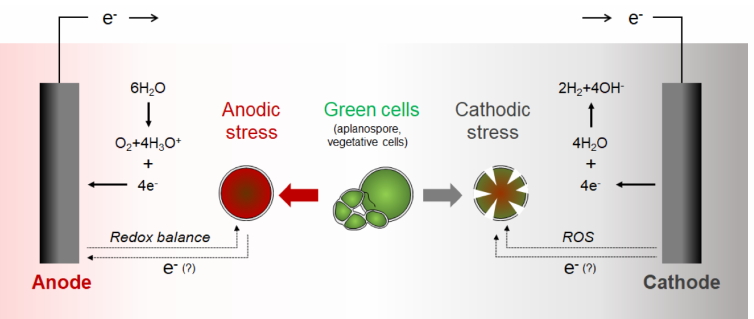
Figure 6. Simple hypothetical schematic of the electric treatment of Haematococcus pluvialis in the two-chamber bioelectrochemical system. ROS, reactive oxygen